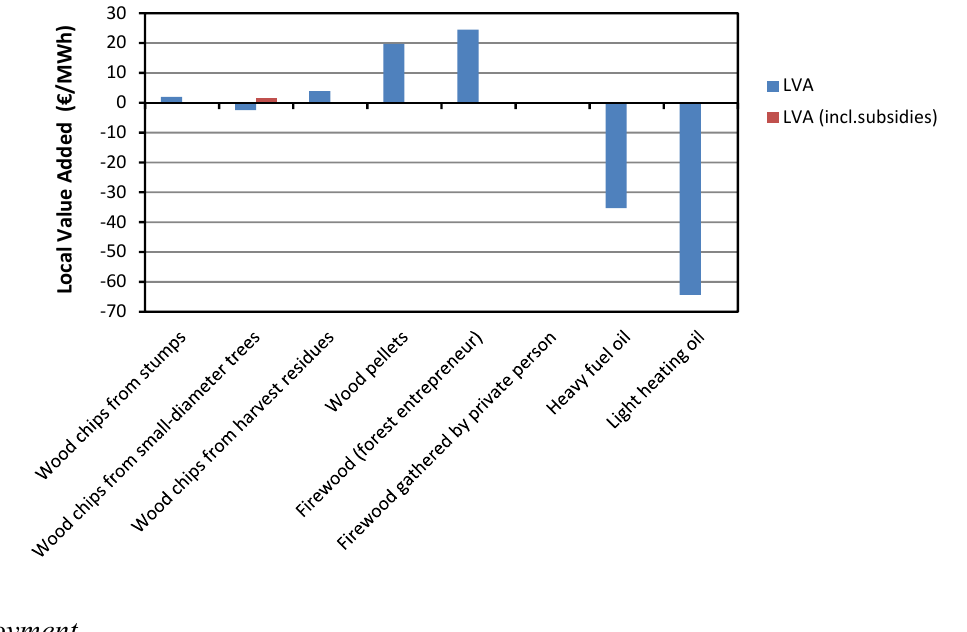
Figure 3. Local added value (€/MWh) of different wood-based and fossil fuels for energy production in North Karelia. The Local added value is defined here as the gross added value remaining in the region of North Karelia. Oil is imported from outside the region and therefore the entire amount which is spent on the procurement of oil is represented by a negative